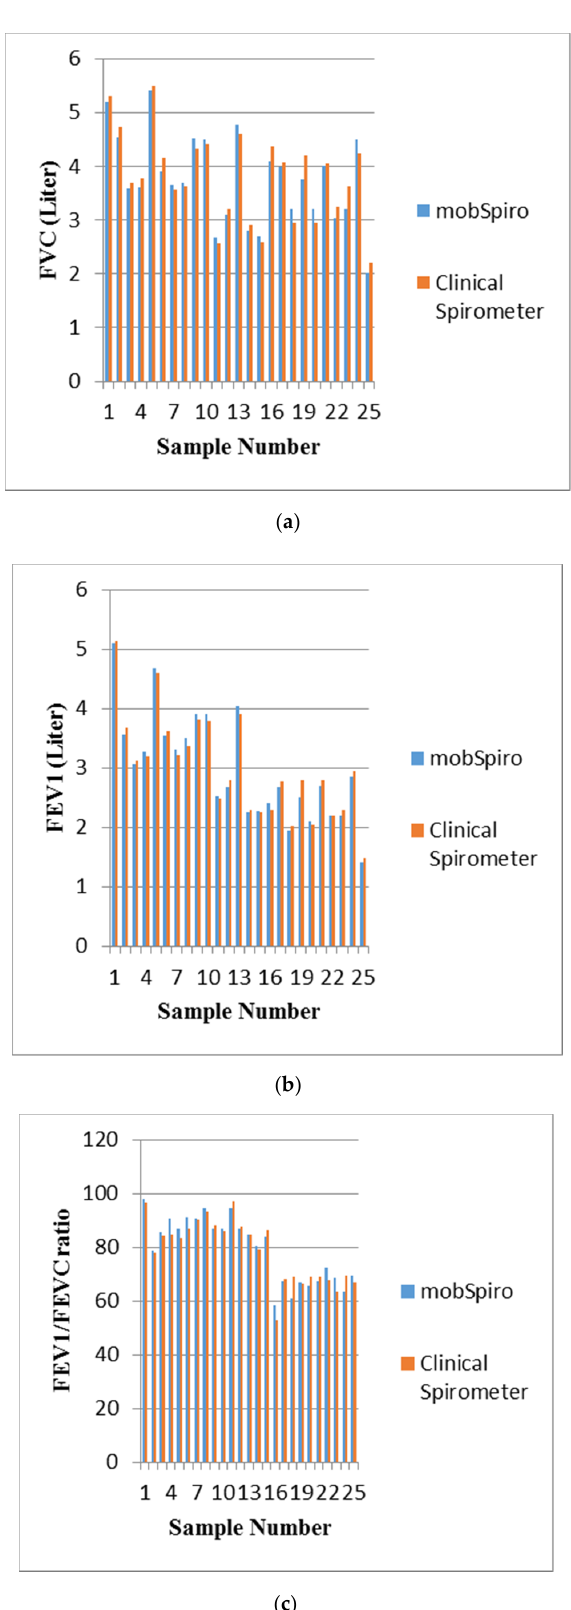
Figure 8. Comparative Graphs. ( a ) FVC differences between mobile and real spirometer results. ( b ) FEV1 differences between mobile and real spirometer results. ( c ) FEV1/FVC ratio differences between mobile and real spirometer results.